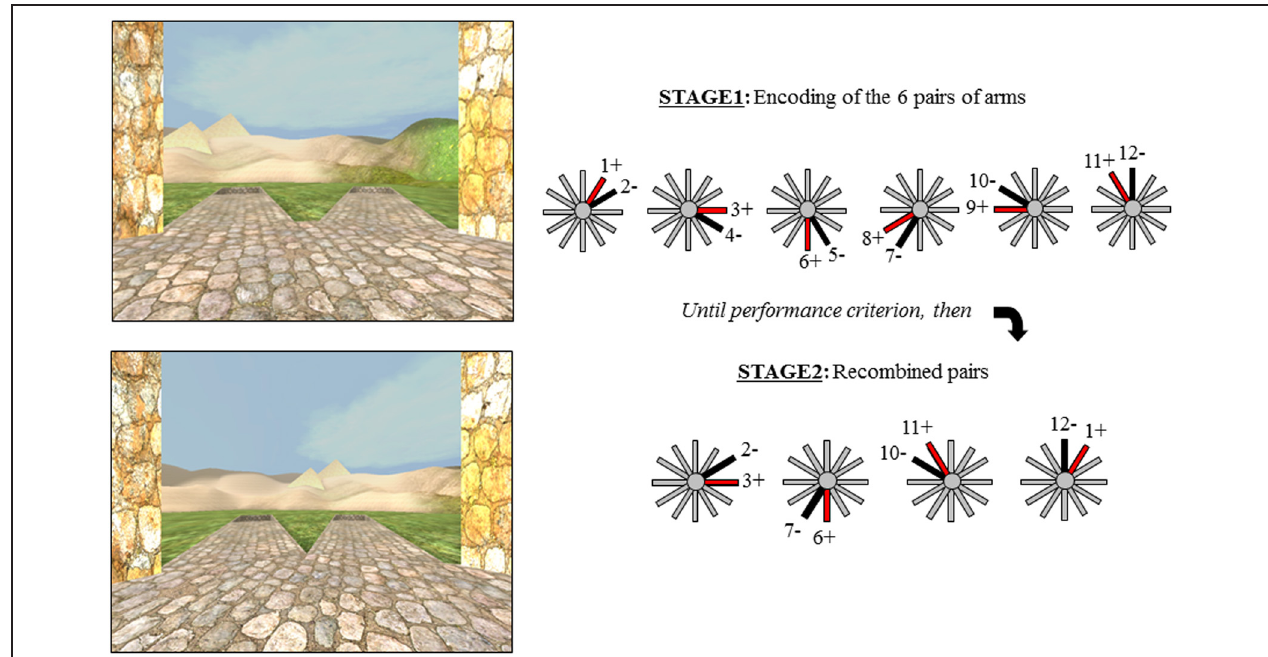
FIGURE 1 | The two stages of the virtual radial maze with a schematic representation of the behavioral paradigm. Example of a pair of arms presented during encoding (Stage 1) and a recombined pair during Stage